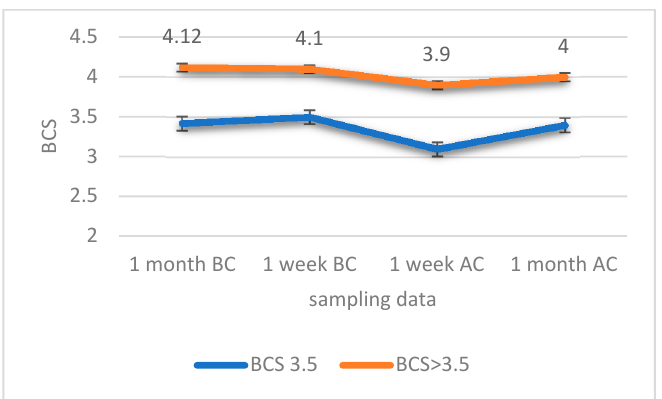
Figure 1. Body condition score (BCS) depending on the time of sampling. Standard error of the mean (SEM) for each group/sampling was 0.13; 0.0; 0.34 and 0.14 for BCS-3.5 heifers, whereas for the BCS > 3.5 group they were 0.3; 0.3; 0.12; and 0.3 for 1 month before calving (BC); 1 week BC; 1 week after calving (AC) and 1 month AC, respectively.